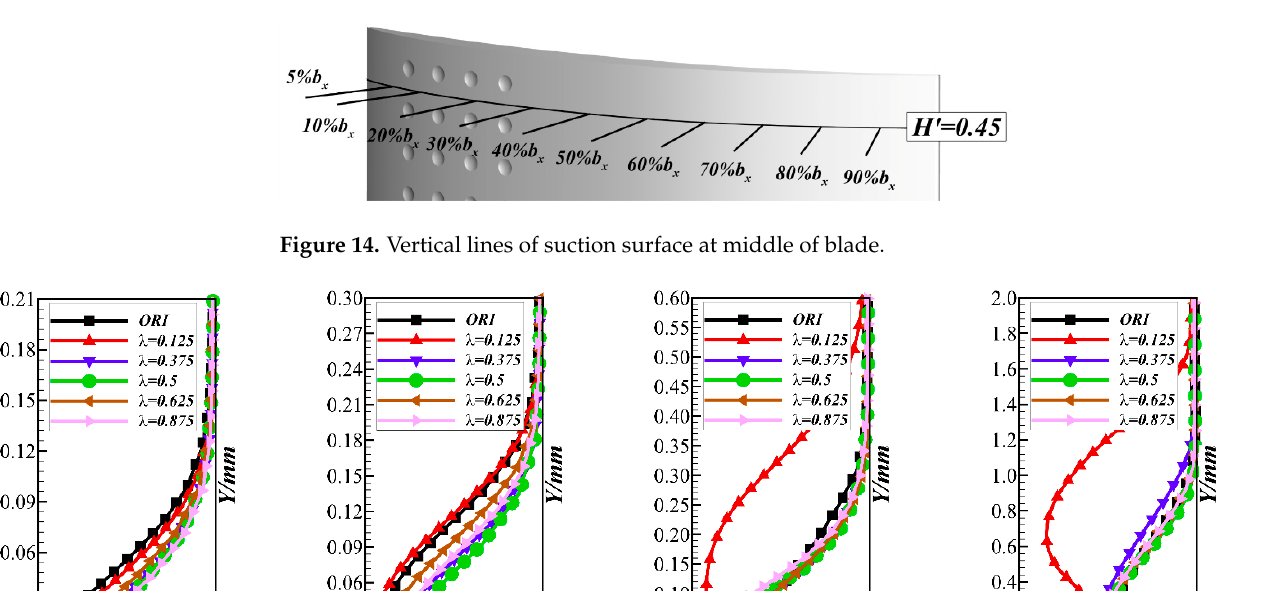
( f ) Figure 13. Limiting streamline of suction surface. ( a ) ORI; ( b ) 𝜆 = 0.125 ; ( c ) 𝜆 = 0.375 ; ( d ) 𝜆 = 0.5 ; ( e ) 𝜆 = 0.625 ; ( f ) 𝜆 = 0.875 . Due to the weakening or elimination of LSB, the flow blockage in the middle of the